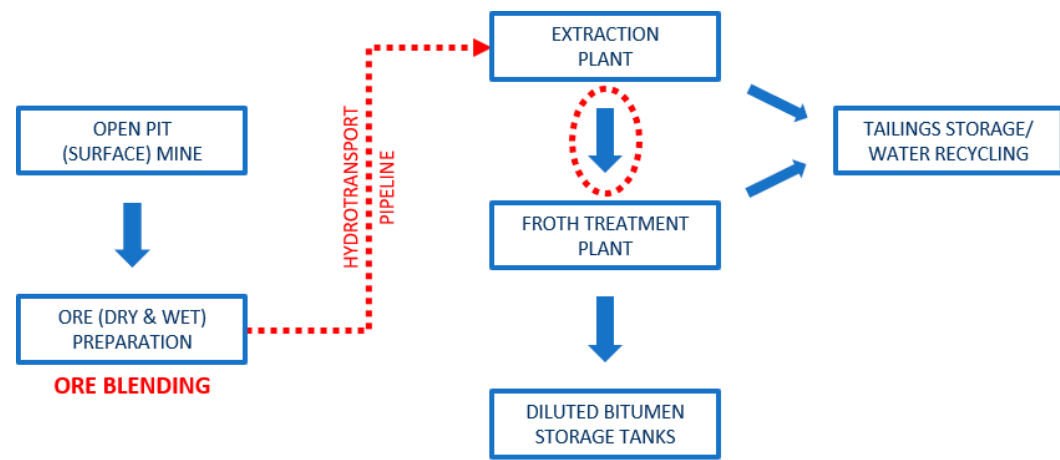
Figure 5. Generalized flowsheet for the extraction of diluted bitumen (“dilbit”) from mined oil sands. Blending should occur during ore preparation (prior to processing) to improve hydrotransport along pipelines [73]. Red dotted ellipse indicates potential additional point of hydrotransport for remote extraction sites.